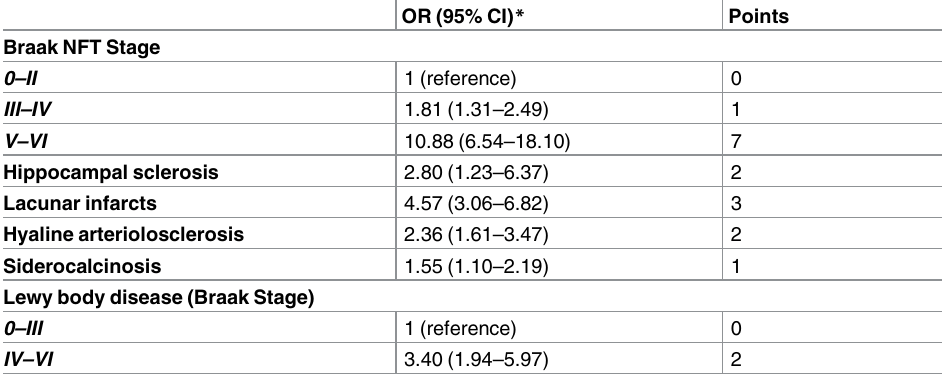
Table 3. Neuropathological lesions that were independently associated with dementia status in multi- variateordinal logistic regression ( n = 1,092).